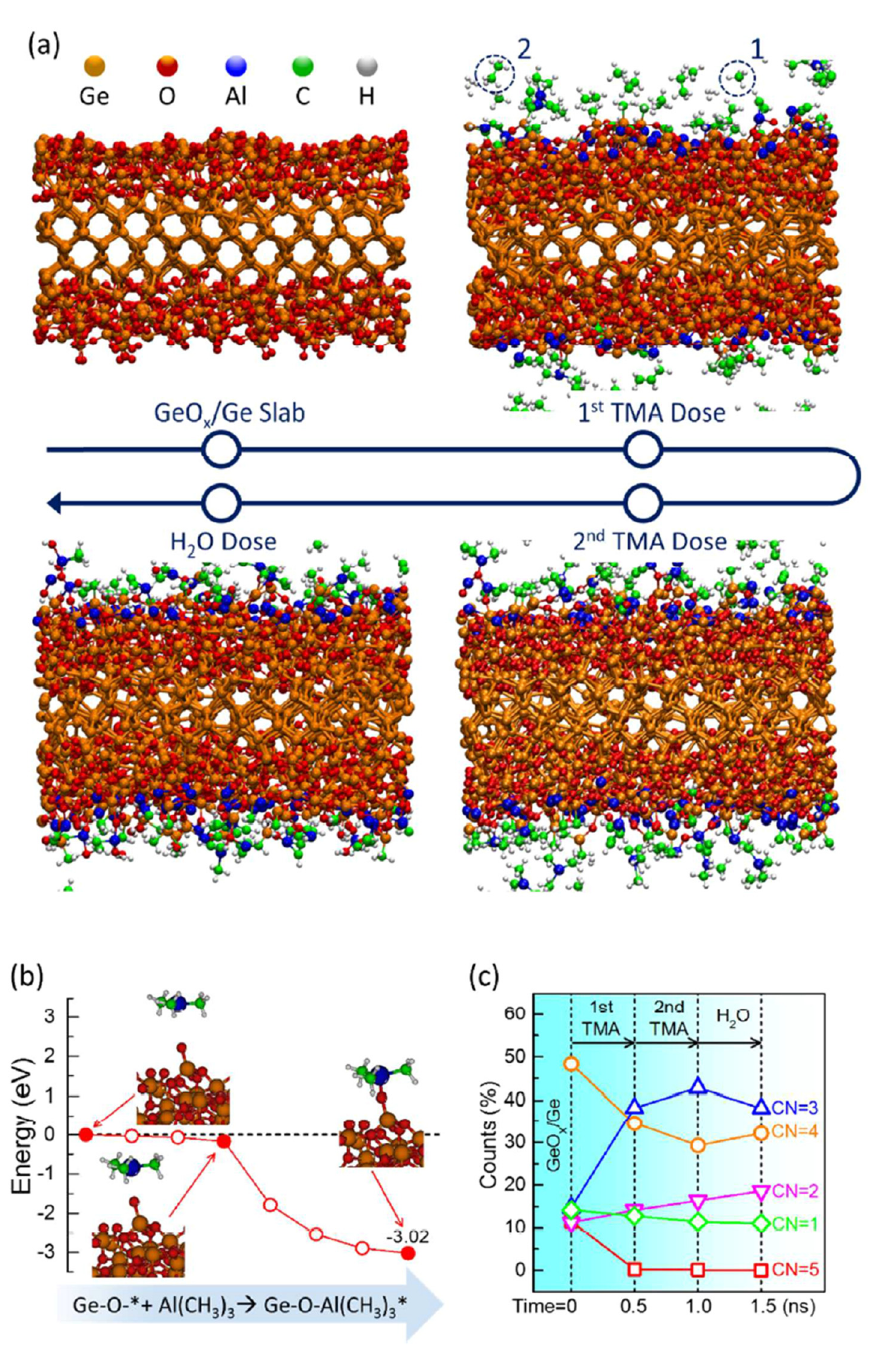
Figure 15: ( a ) Schematics of ReaxFF - MD calculations at 1,000 K of consecutive deposition of TMA and H20 dosages on a GeOx/Ge substrate resulting in Al 2 O 3 ALD. ( b ) The absorption of TMA precursor on the surface of GeOx/Ge during ReaxFF - MD simulation. The marked molecules ( 1 and 2 ) in the fi rst TMA dosage snapshot are by - products of H - CH ( c ) Numerical representation of the oxygen atoms that were 3 C 3 and CH 4 . coordinated to Ge in the Al 2 O 3 ALD simulation performed using ReaxFF - MD on GeOx/Ge [ 10 ]